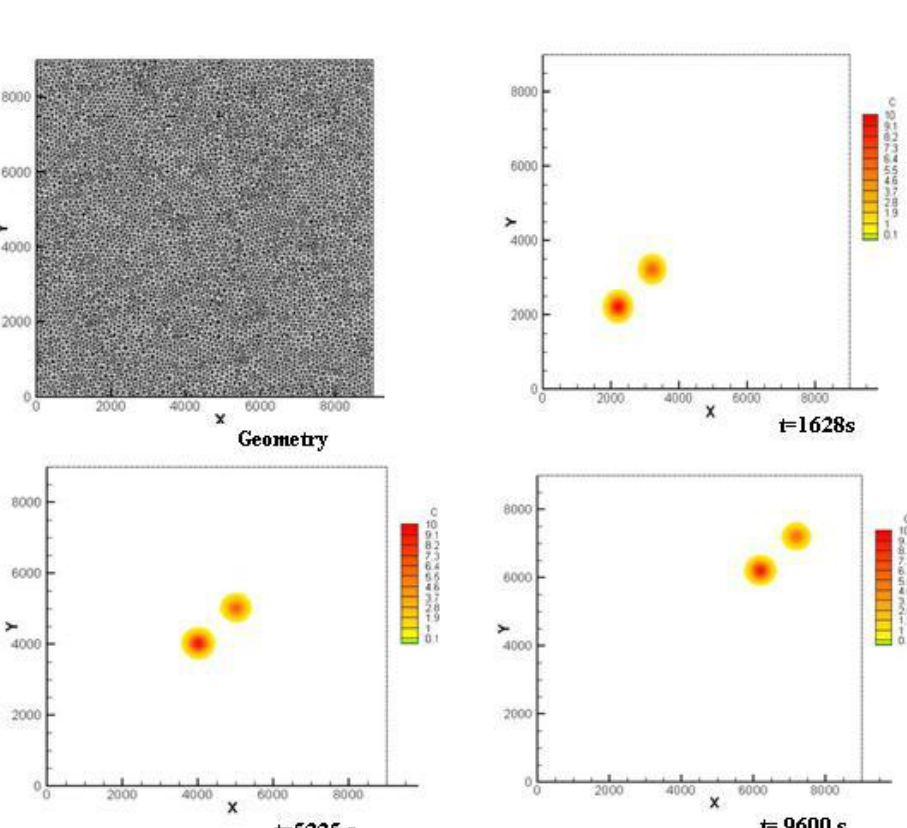
Fig. 2 adopted cavity meshes and the advection results throughout 3 different times. Which are comparable to the results given in Benkhaldoun's paper (2007) as in figure